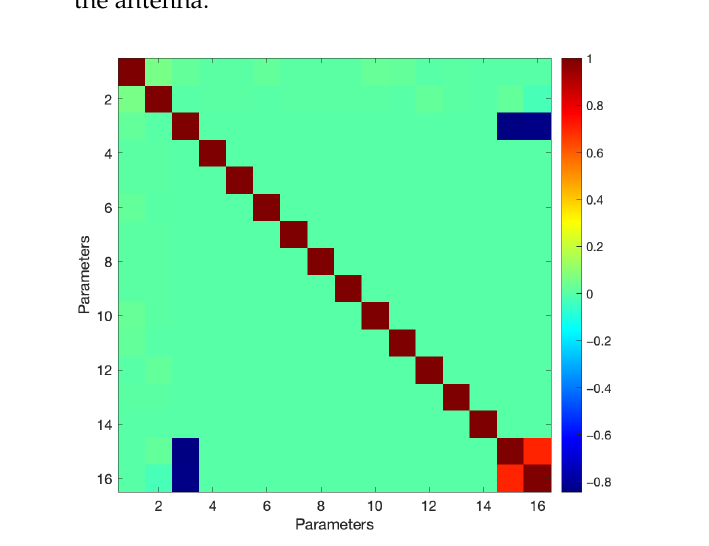
Figure 9. Correlation between parameters after TLS adjustment. All correlations are resolved except the one between the UP component ( γ ) and the slant heights of the vertical